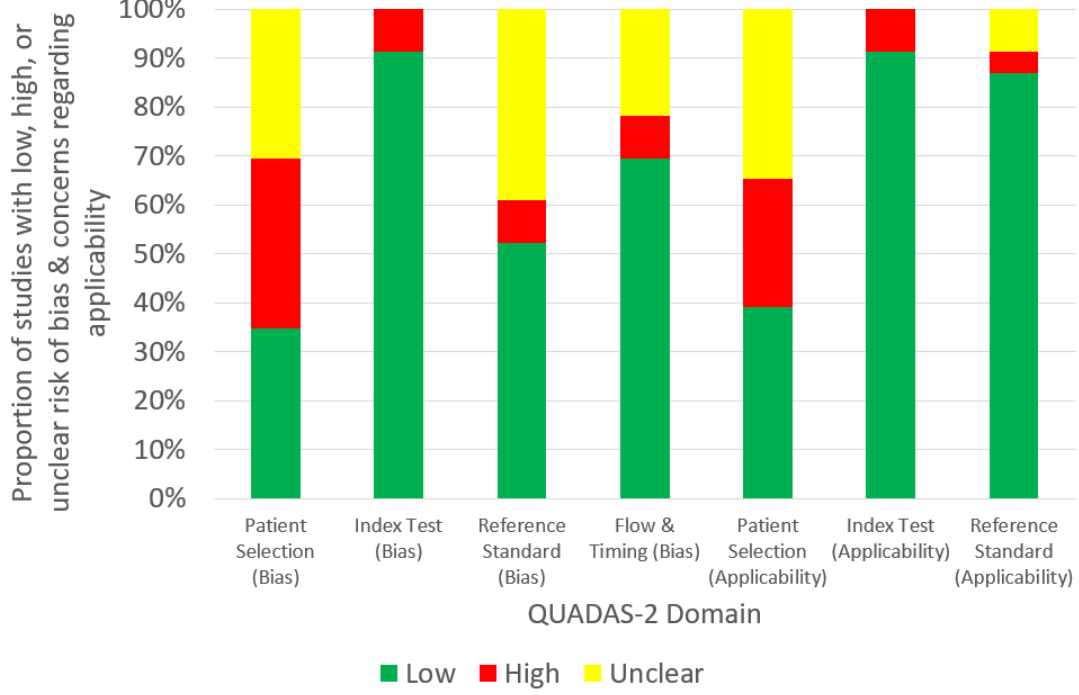
Figure 2. Quality assessment summary of all (23) included studies based on Revised Quality Assessment of Diagnostic Accuracy Studies tool.